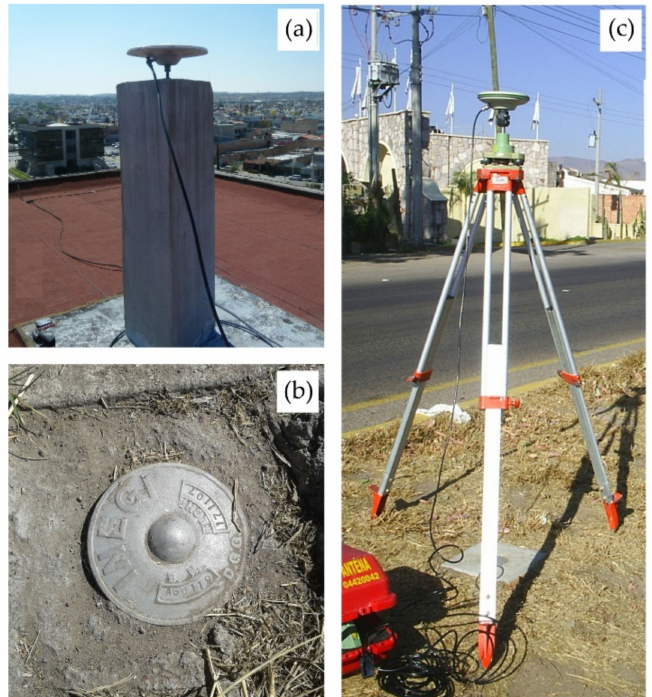
Figure 3. ( a ) INEG permanent station monument; ( b ) typical benchmark for GNSS and leveling network stations, and ( c ) monitoring benchmark surveying using geodetic GNSS